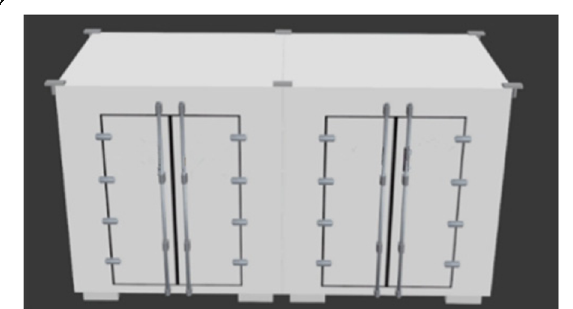
Fig. 4 Refrigerated containers that can be placed on a semi-trailer. The refrigerated containers can ensure the constant temperature in the containers. At the same time, the insulation board is placed in the refrigerator car to cut off the area of different temperatures in the refrigerated containers. In this way, the refrigerated containers can be loaded with cold chain cargo or normal temperature cargo, so that three temperature regions can be divided in a refrigerated container. The insulation boards can be moved forward and backward, it can be pushed to the side of the container when it is not needed. There are two baffles inside the refrigerated container, which are used to separate the areas and have a temperature control device on the container. The position of the baffle can be adjusted with the size of the goods to avoid the problem that the large goods cannot be